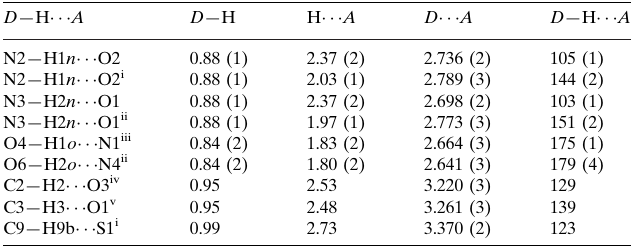
Data collection: CrystalClear (Molecular Structure Corporation & Rigaku, 2005); cell refinement: CrystalClear ; data reduction: Crys- talClear ; program(s) used to solve structure: SHELXS97 (Sheldrick, 2008); program(s) used to refine structure: SHELXL97 (Sheldrick, 2008); molecular graphics: ORTEPII (Johnson, 1976) and DIAMOND (Brandenburg, 2006); software used to prepare material for publication: publCIF (Westrip,